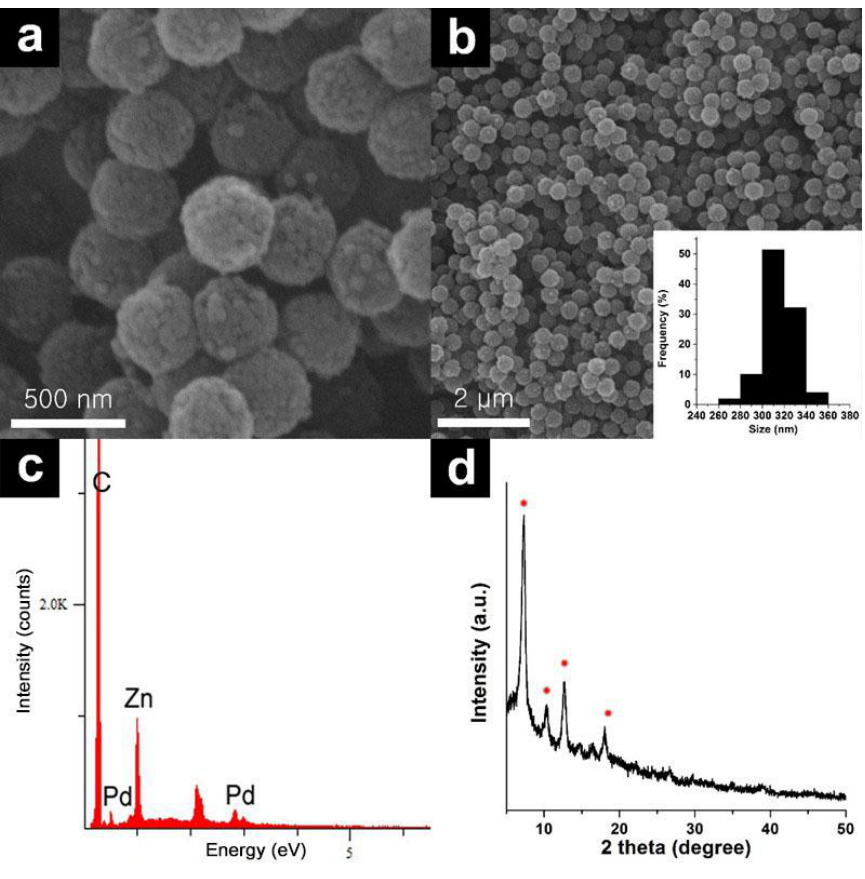
Figure 3. SEM images ( a , b ); EDS spectrum ( c ) and XRD patterns ( d ) of Pd/PS@ZIF-8